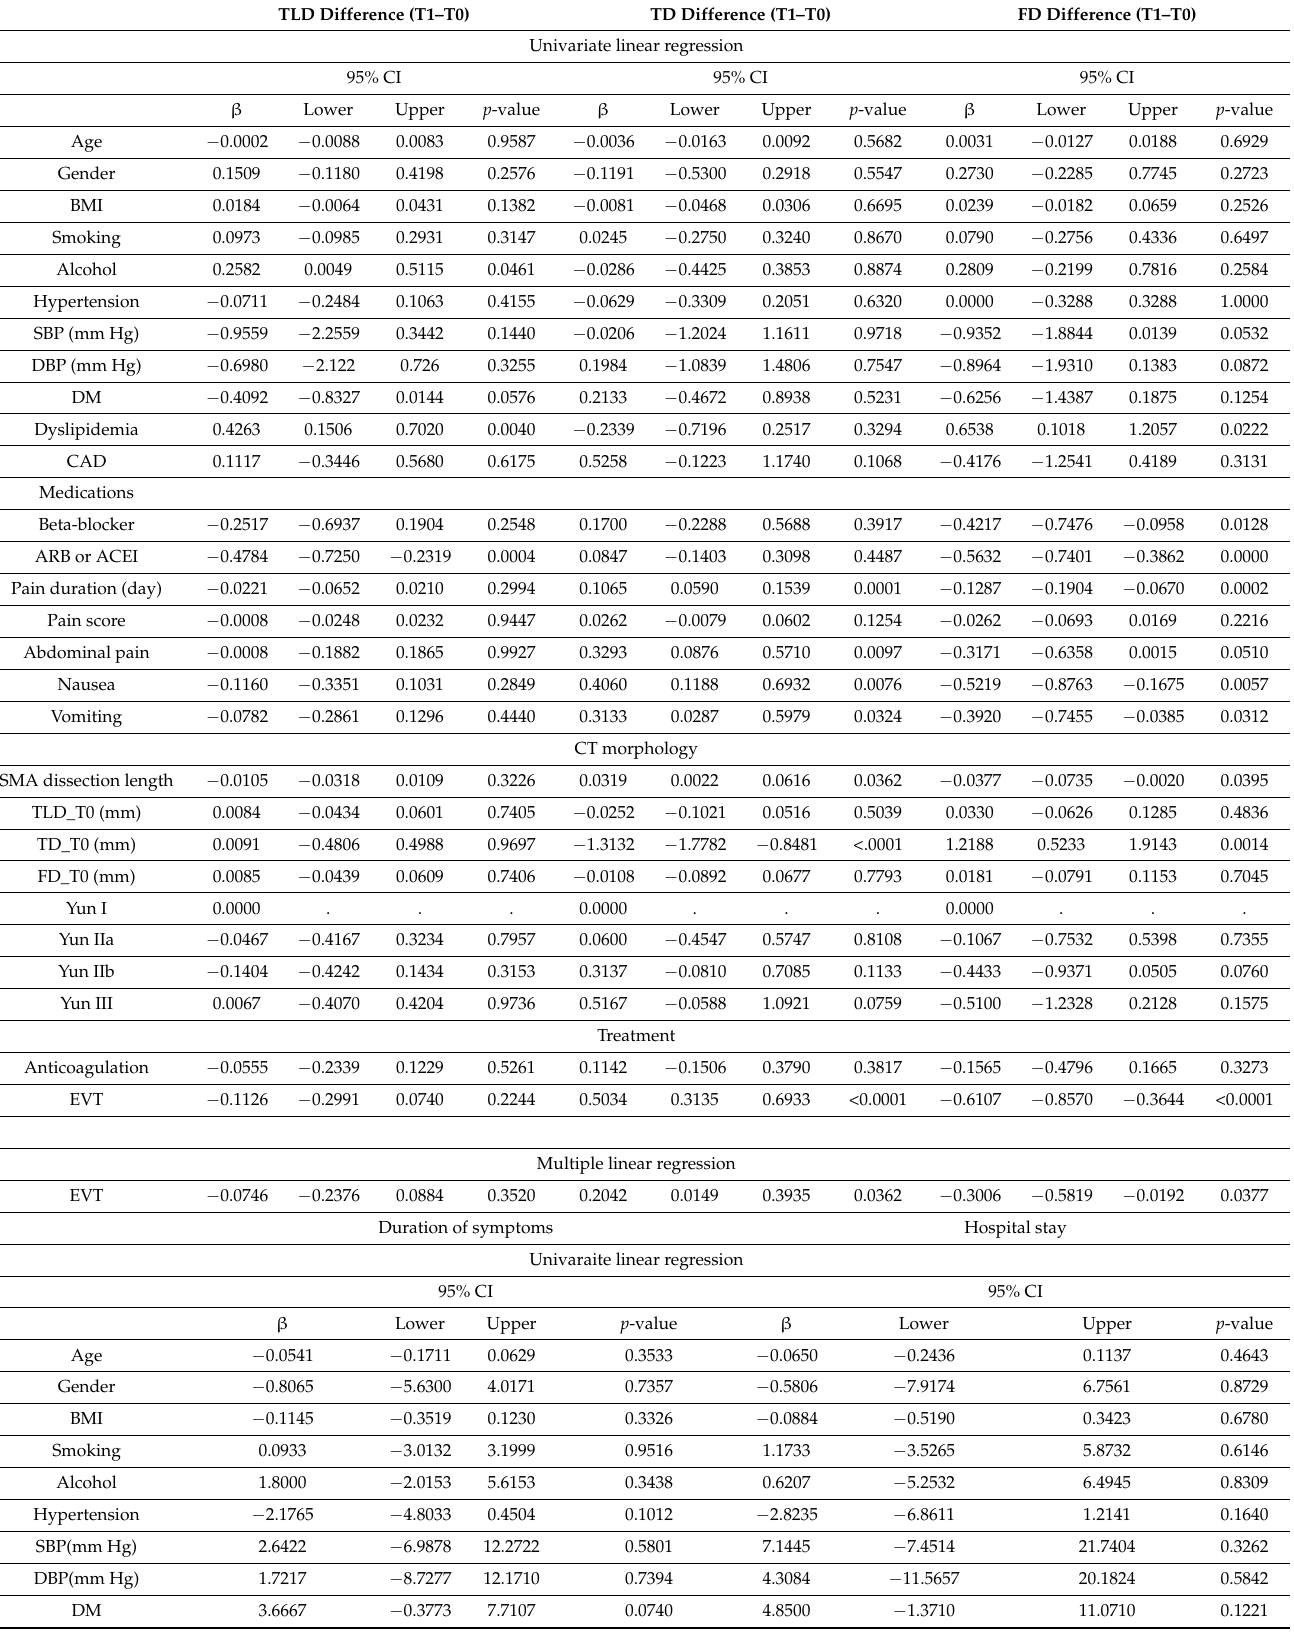
Table 2. Univariate and multivariate